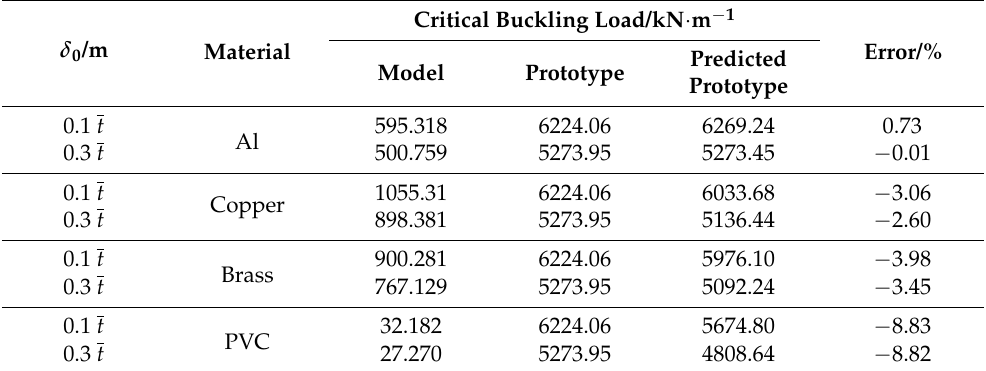
Table 9. Partial similitude simulation for post-buckling of LRRSC under axial